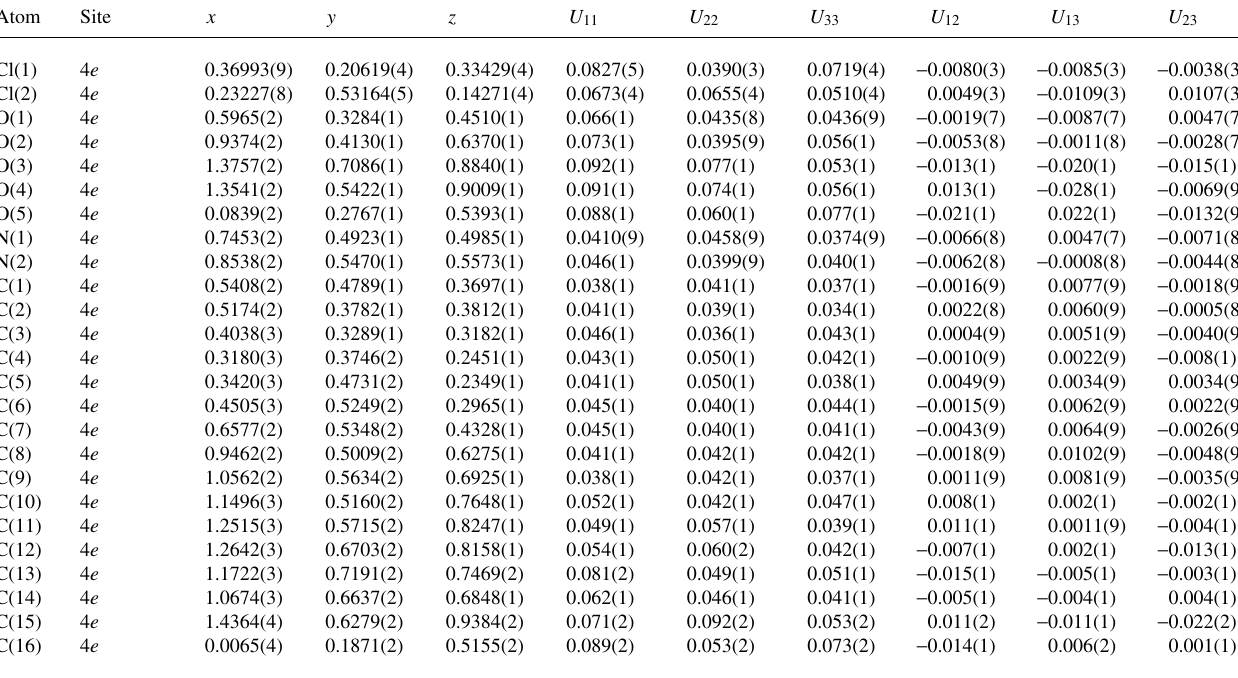
Table 3. Atomic coordinates and displacement parameters (in Å 2 )